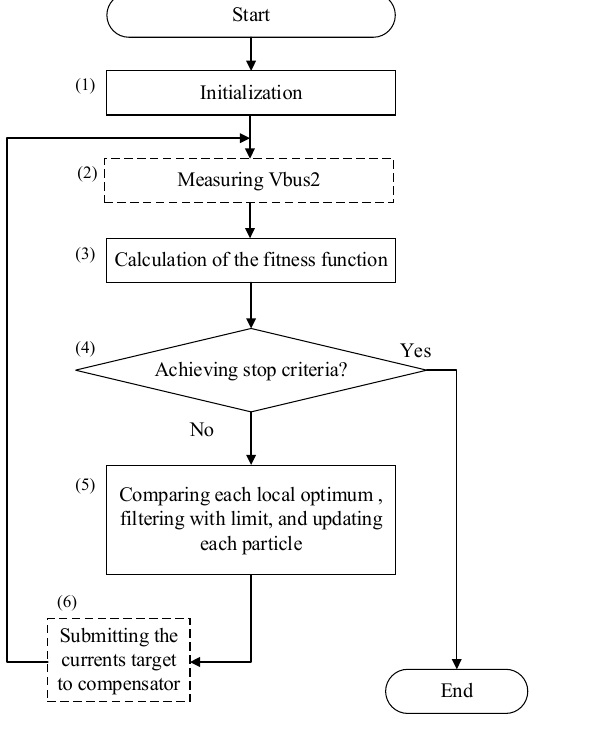
Figure 4. Flow chart of PSO.